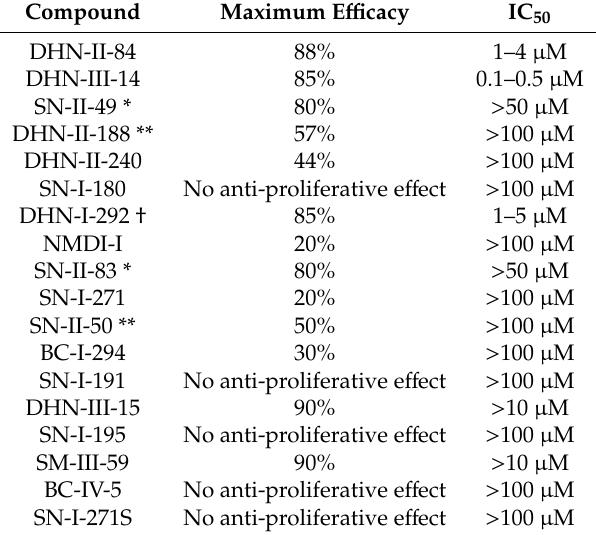
efficacy only seen in H727 and TT cell lines.